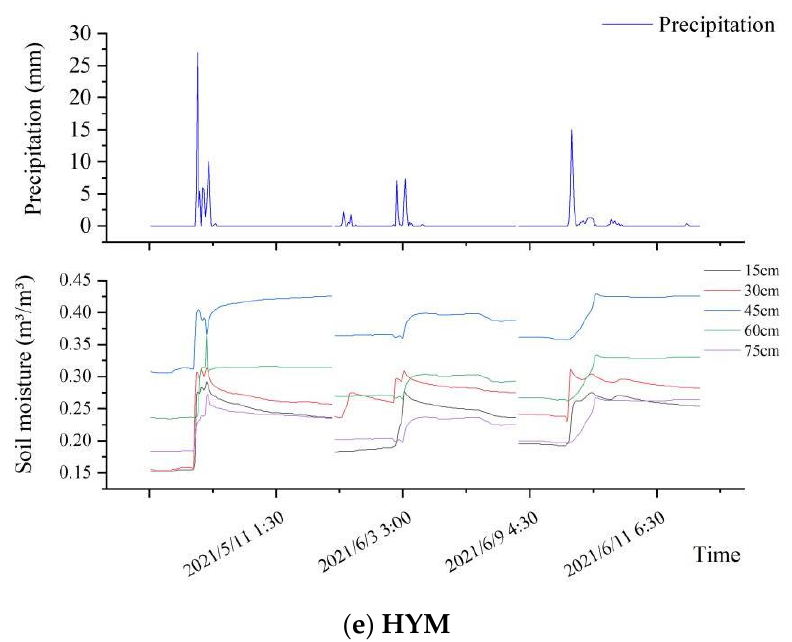
Figure 5. Precipitation and soil moisture of different agroforestry. (C. Secondary forest; YSH. Poplar, Ryegrass ; YMH. Corn, Ryegrass ; HTY. Walnut, Corn ; HYM. Walnut, Corn, Potato ).